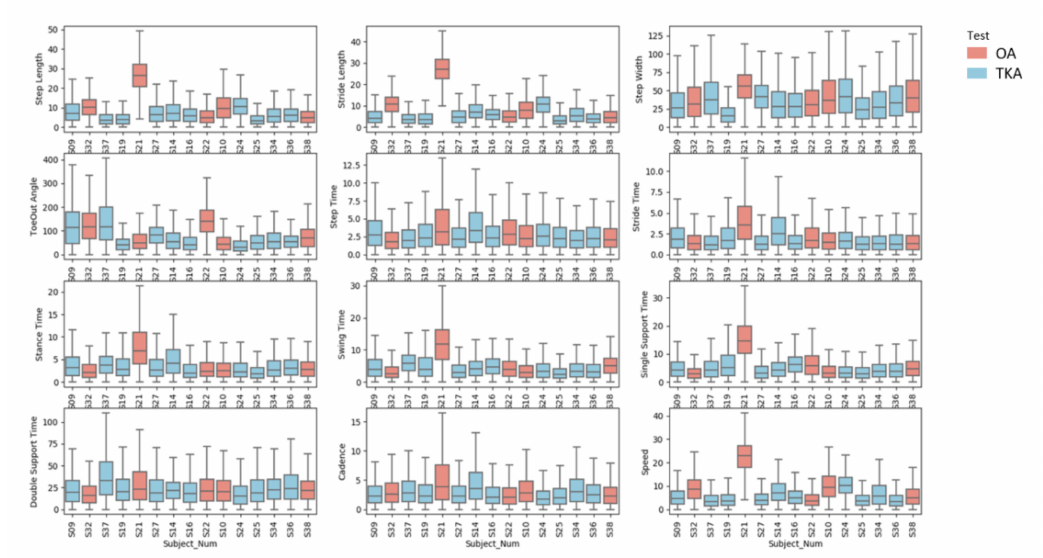
Figure A2. Boxplot associated with NAPEs of each test subjects grouped by their knee status (OA and TKA) for test